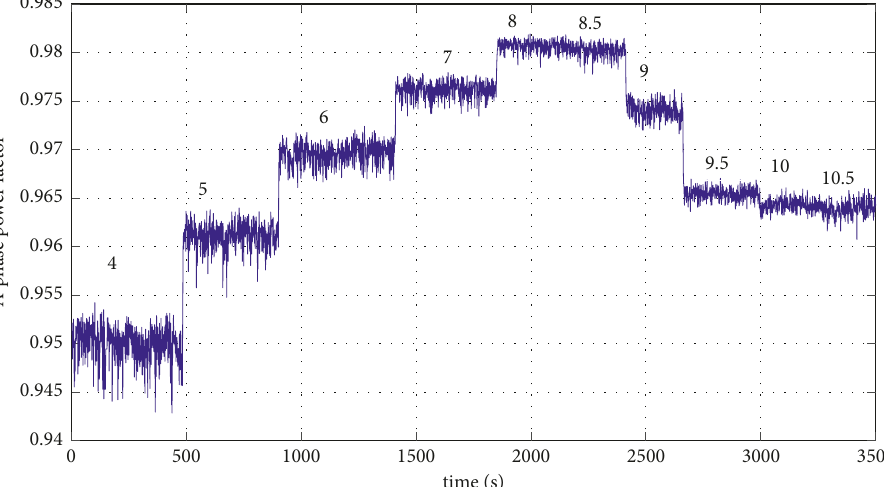
Figure 14: A-phase power factor.